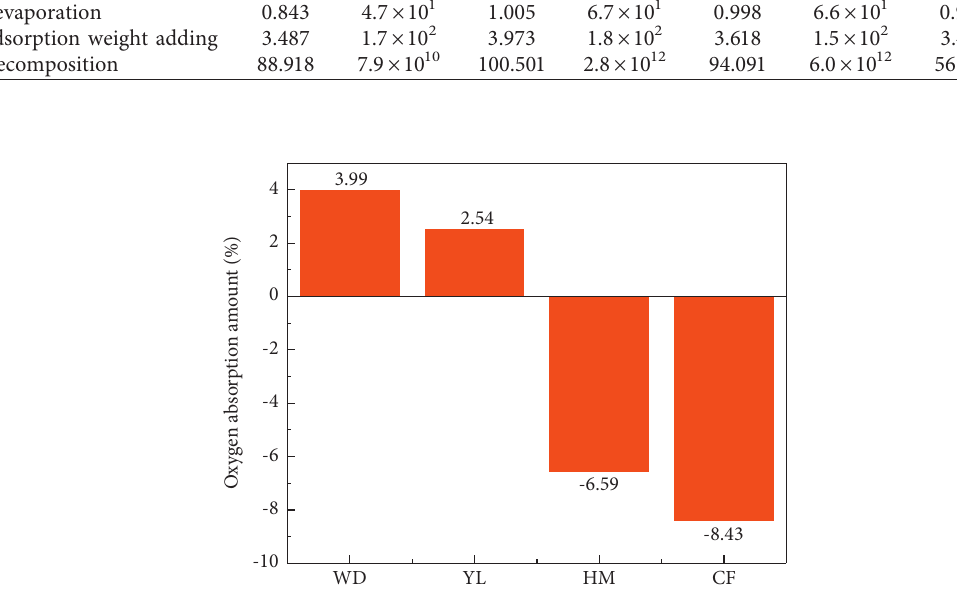
Figure 4: Oxygen-adsorption amount of the samples.